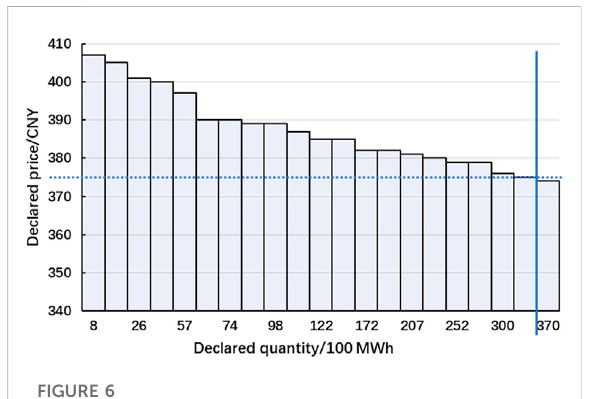
FIGURE 6 The results of clearing in the market of Scenario